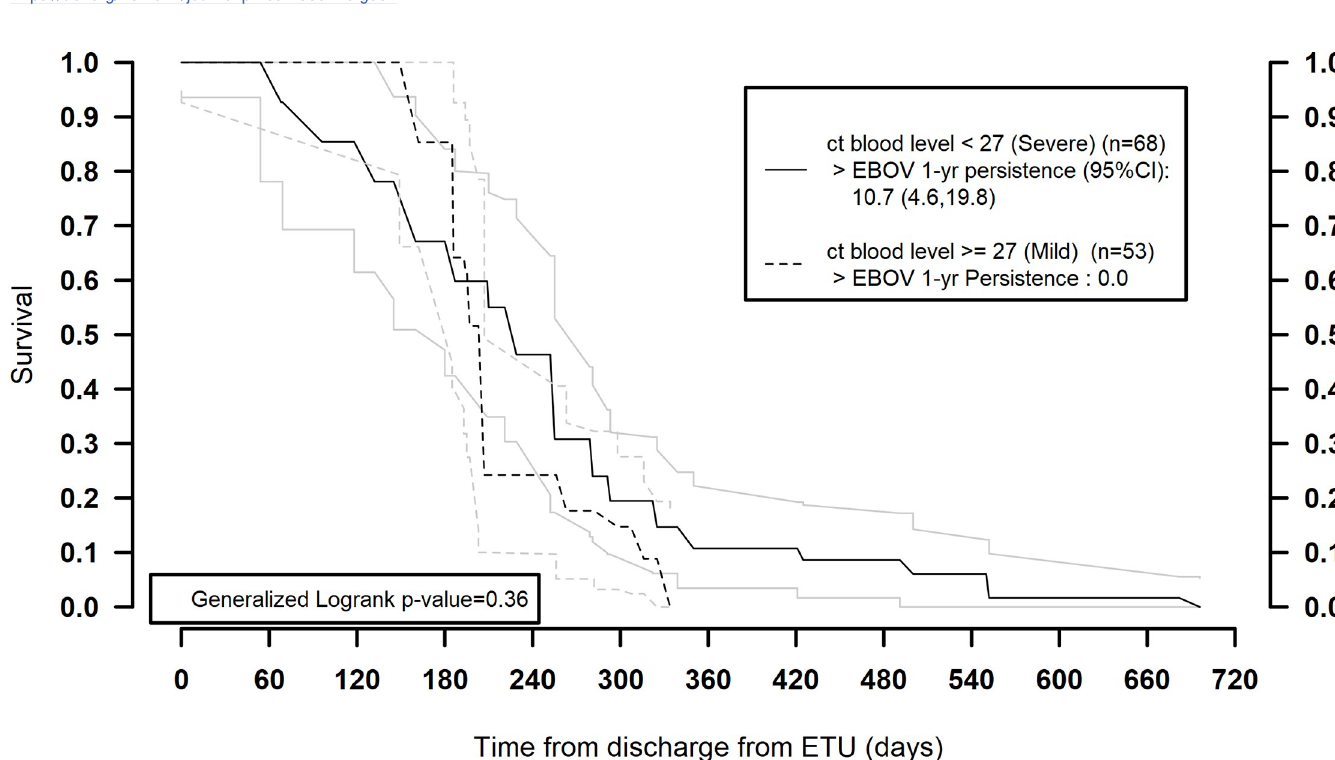
Fig 1. Survival function (Kaplan–Meier analysis) of Ebola virus RNA persistence in semen over time since ETU discharge, with Weibull fit. ETU, Ebola treatment unit; IC, interval-censored; KM, Kaplan–Meier.